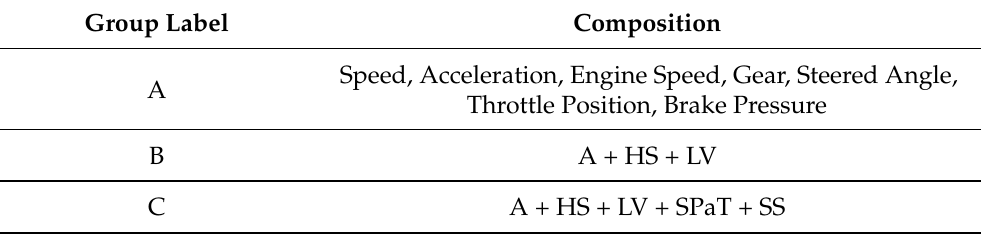
Table 10. Data Groups for LSTM DNN.